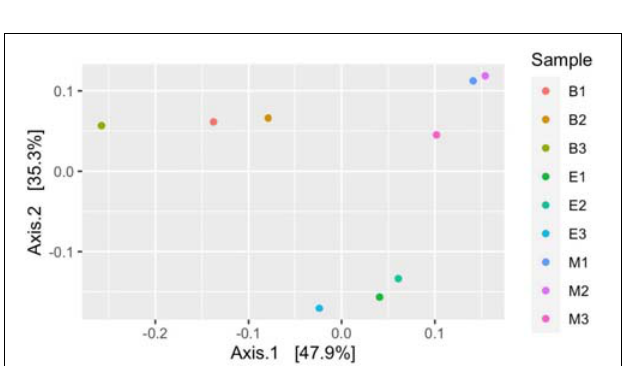
FIGURE 6 | Comparative “k-dominance” curve to predict dominance pattern of ASVs for three universal prokaryote primers in each wetland. The abbreviations and numerics used are as follows: B, Bhomra; E, EKW; M, Malencho; 1, 341b4_F/806_R; 2, N341b4_F/806_R; 3, Pro341F/Pro805R; ASV, amplicon sequence variant; EKW, East Kolkata wetland.